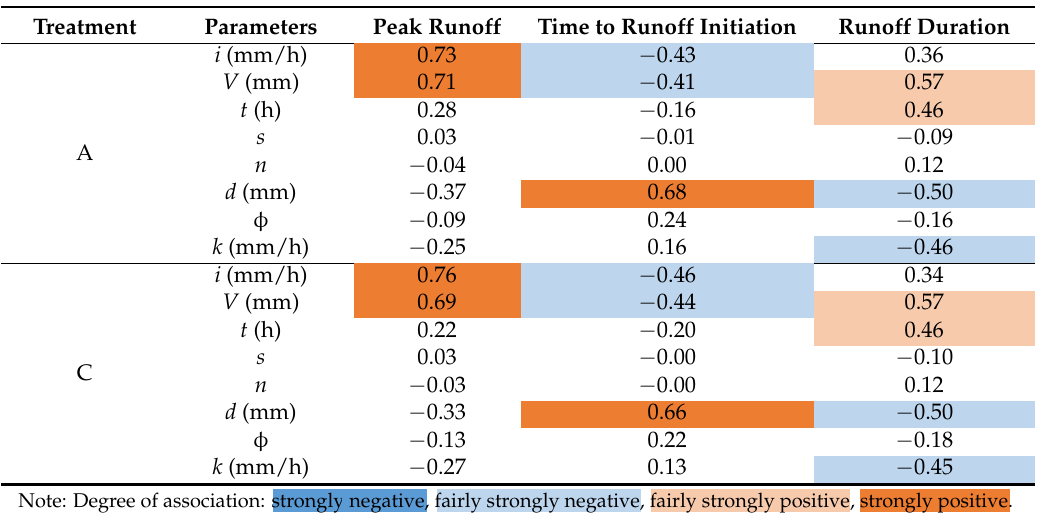
Table 5. Correlation matrix for Treatments A and